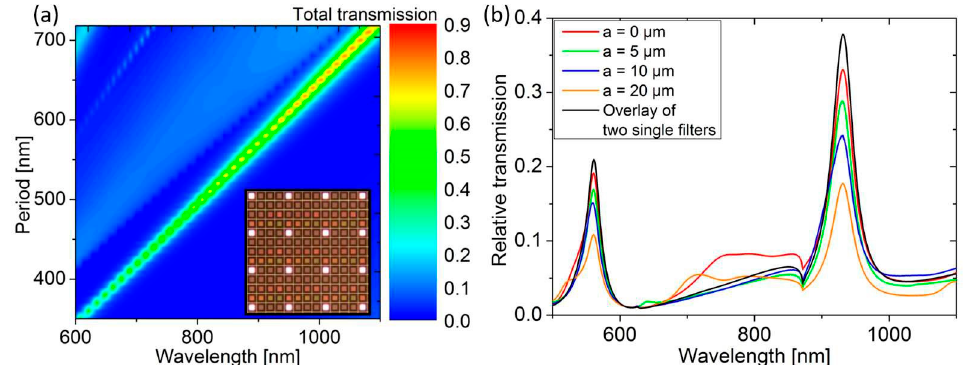
Figure 2. ( a ) Simulated transmission spectra of GMR filter with grating period ranging from 350 nm to 710 nm, covering the wavelength from 600 nm to 1100 nm. Inset shows fabricated filter matrix consisting of 15 individual filters and a hole cell without metal coating; ( b ) Simulated transmission spectra of two filters with distance of 0 µm, 5 µm, 10 µm, 20 µm and their single spectra overlay. These two filters have periods of 300 nm and 600 nm,